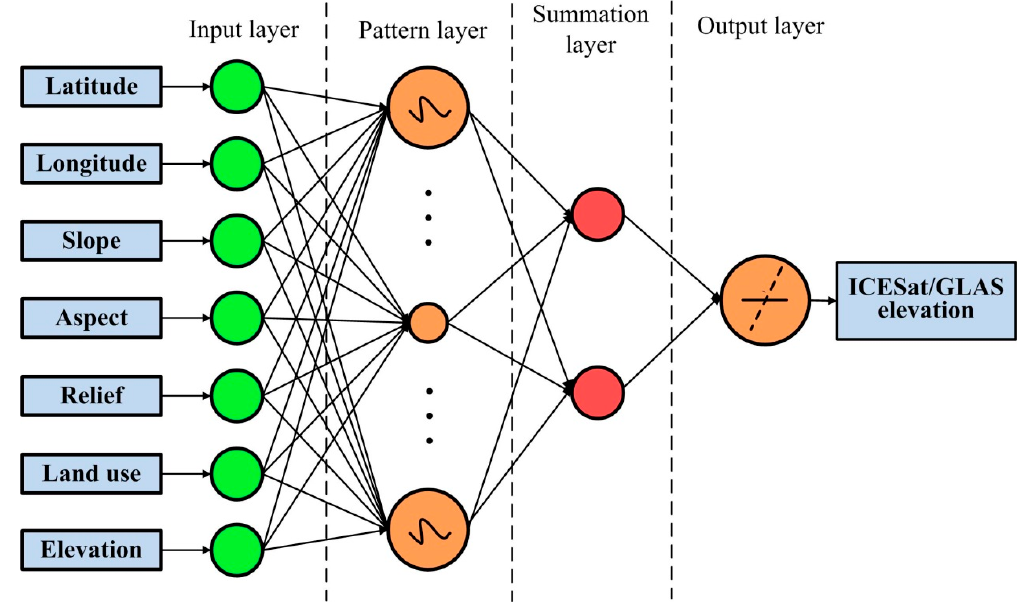
Figure 4. Structure of generalized regression NN (GRNN) for SRTM3 DEM correction.